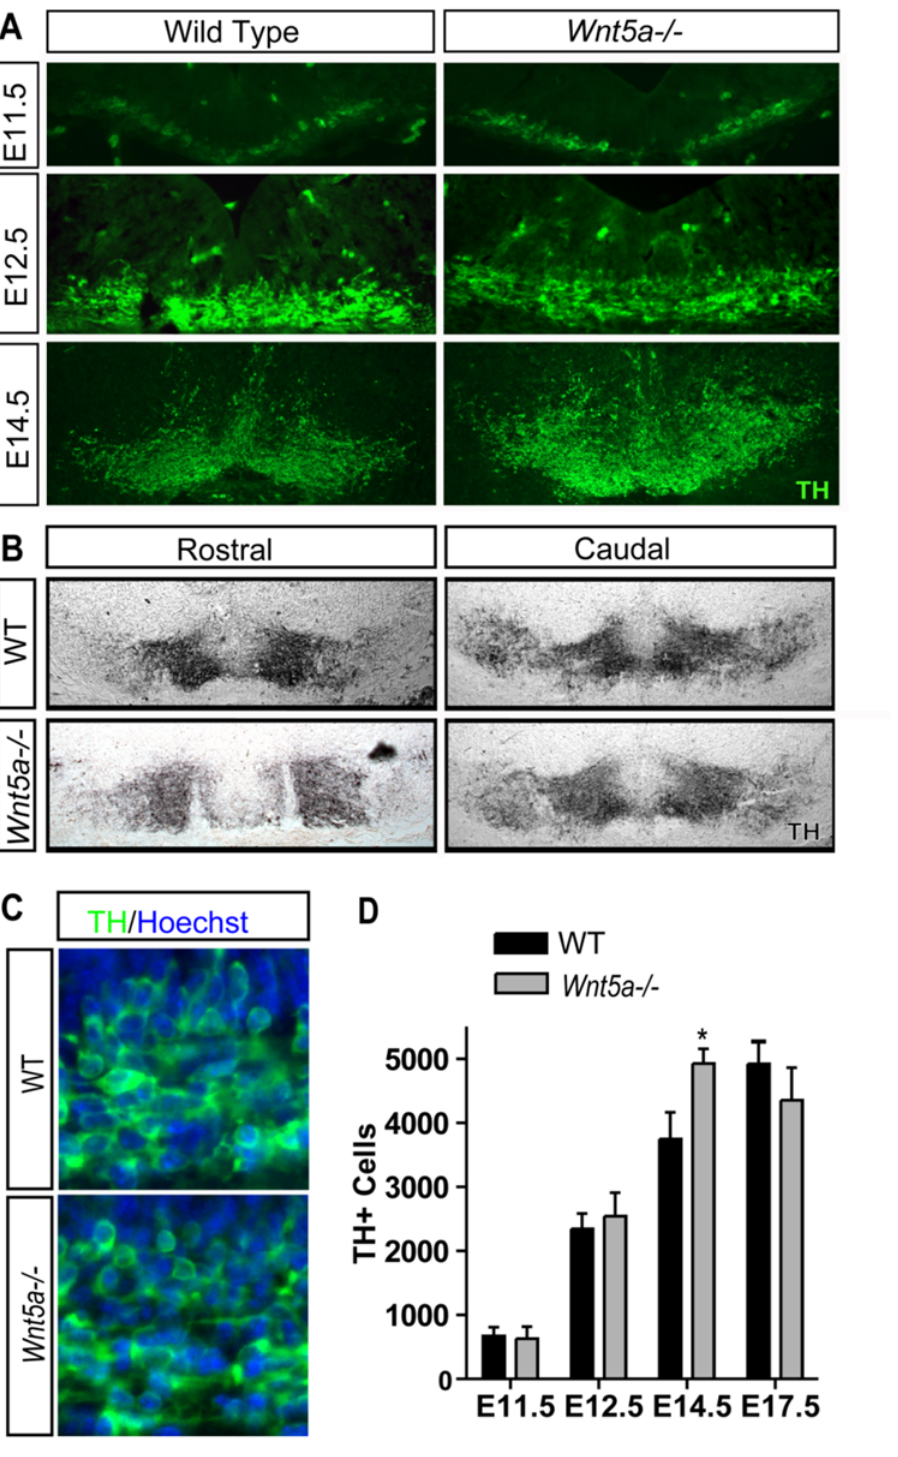
Figure 3. The number of dopaminergic neurons is normal at most stages but transiently increases at E14.5 in Wnt5a 2 / 2 mice. (A) At E11.5 and E12.5 no differences in the number of TH + cells could be detected. At E12.5 and E14.5 the region occupied by TH + cells in the Wnt5a 2 / 2 midbrain appears larger, extending both laterally and dorsally. (B) At E17.5 the distribution of cells is broader dorsoventrally in rostral and caudal sections in the Wnt5a 2 / 2 VM. Importantly, at rostral levels the ventral tegmental area was more lateral (leaving a TH-poor midline domain) and the substantia nigra more medial, making it difficult to differentiate between them. (C) Enlarged image of TH + cells at E12.5 shows normal DA neuron morphology in the Wnt5a 2 / 2 mice. (D) Quantification of the number of TH + cells in E11.5, E12.5, E14.5, and E17.5 mice shows a transient 25% increase at E14.5 in Wnt5a 2 / 2 embryos, which was no longer seen at E17.5. (At E14.5, unpaired t-test, p=0.0492, N=4).